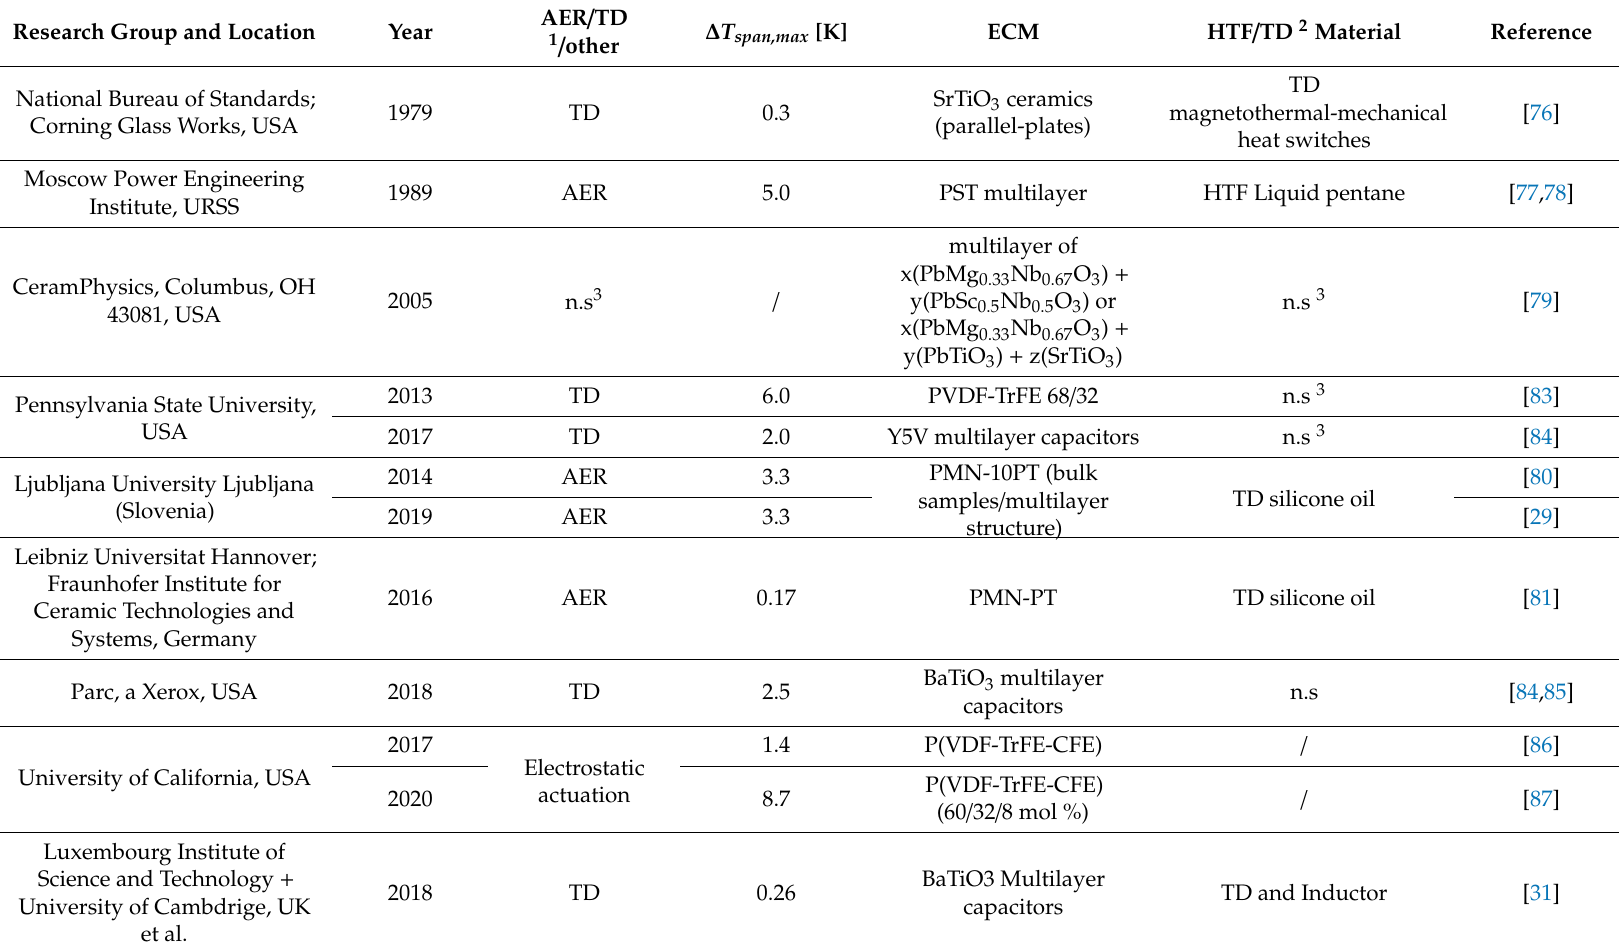
Table 5. The experimental electrocaloric devices introduced in literature up to